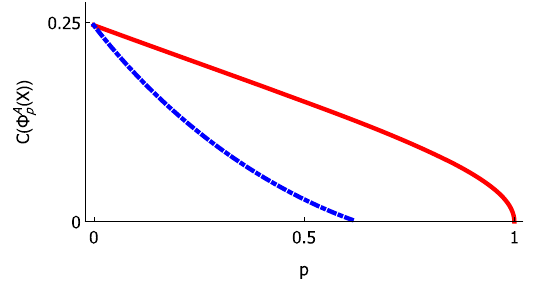
Figure 3. The red and blue curves correspond to situations with amplitude damping channel on qubit U and L , respectively. Influence of the noise on qubit L leads to sudden death of entanglement, but when the noise affects the qubit U , entanglement decays asymptotically. We chose the input state as ρ ρ ρ = . = . = . 0 35, 0 4, 0 05 and ρ = . 0 2 44